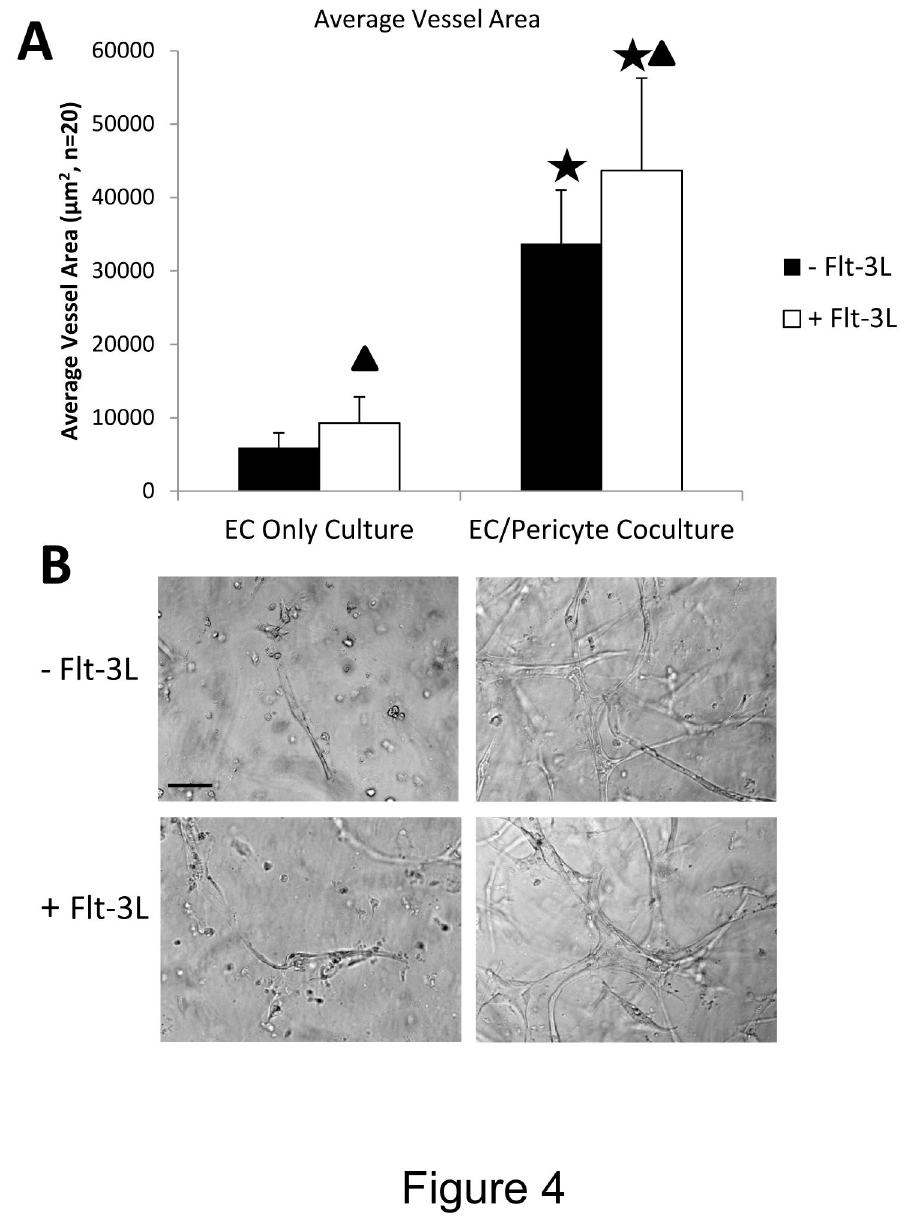
Figure 4. Pericytes and Flt-3L enhance the ability of SCF, IL-3, SDF-1α and FGF-2 to stimulate EC tubulogenesis in 3D fibrin matrices. ECs were seeded with or without pericytes and hematopoietic stem cell cytokines (SCF, IL-3, SDF-1α, FGF-2) were added into the fibrin matrices in the presence or absence of Flt-3L. After 72 hr, cultures were fixed, photographed (B), and quantitated for EC tube formation using Metamorph Software (A). Asterisks indicate significance at p< .01 with respect to the EC only cultures, while the triangles indicate significance at p< .01 with respect to cultures without Flt-3L addition (n=20, values are averaged + SD). Bar equals 25